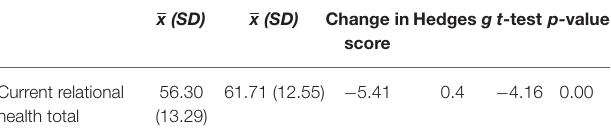
TABLE 10 | Change over time as measured by the NMT current relational health